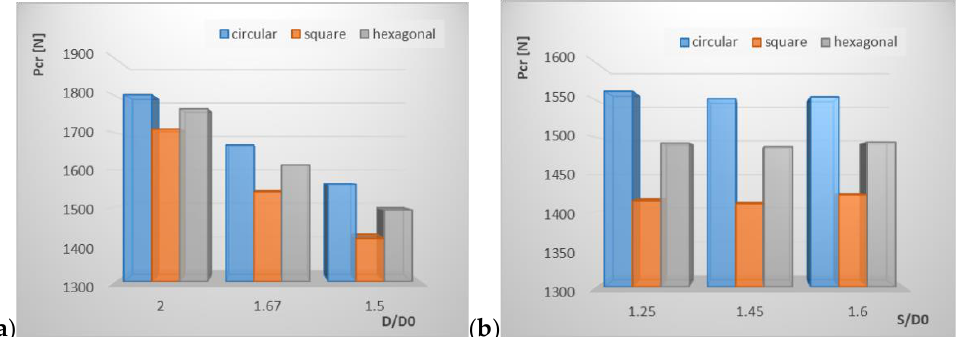
Figure 7. The effect of opening ratio ( a ) and spacing ratio ( b ) on buckling load for three different hole shapes.